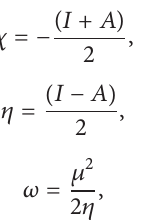
ligands; in order to calculate from the theoretical point of view their geometric and spectroscopic properties, as well as chemical